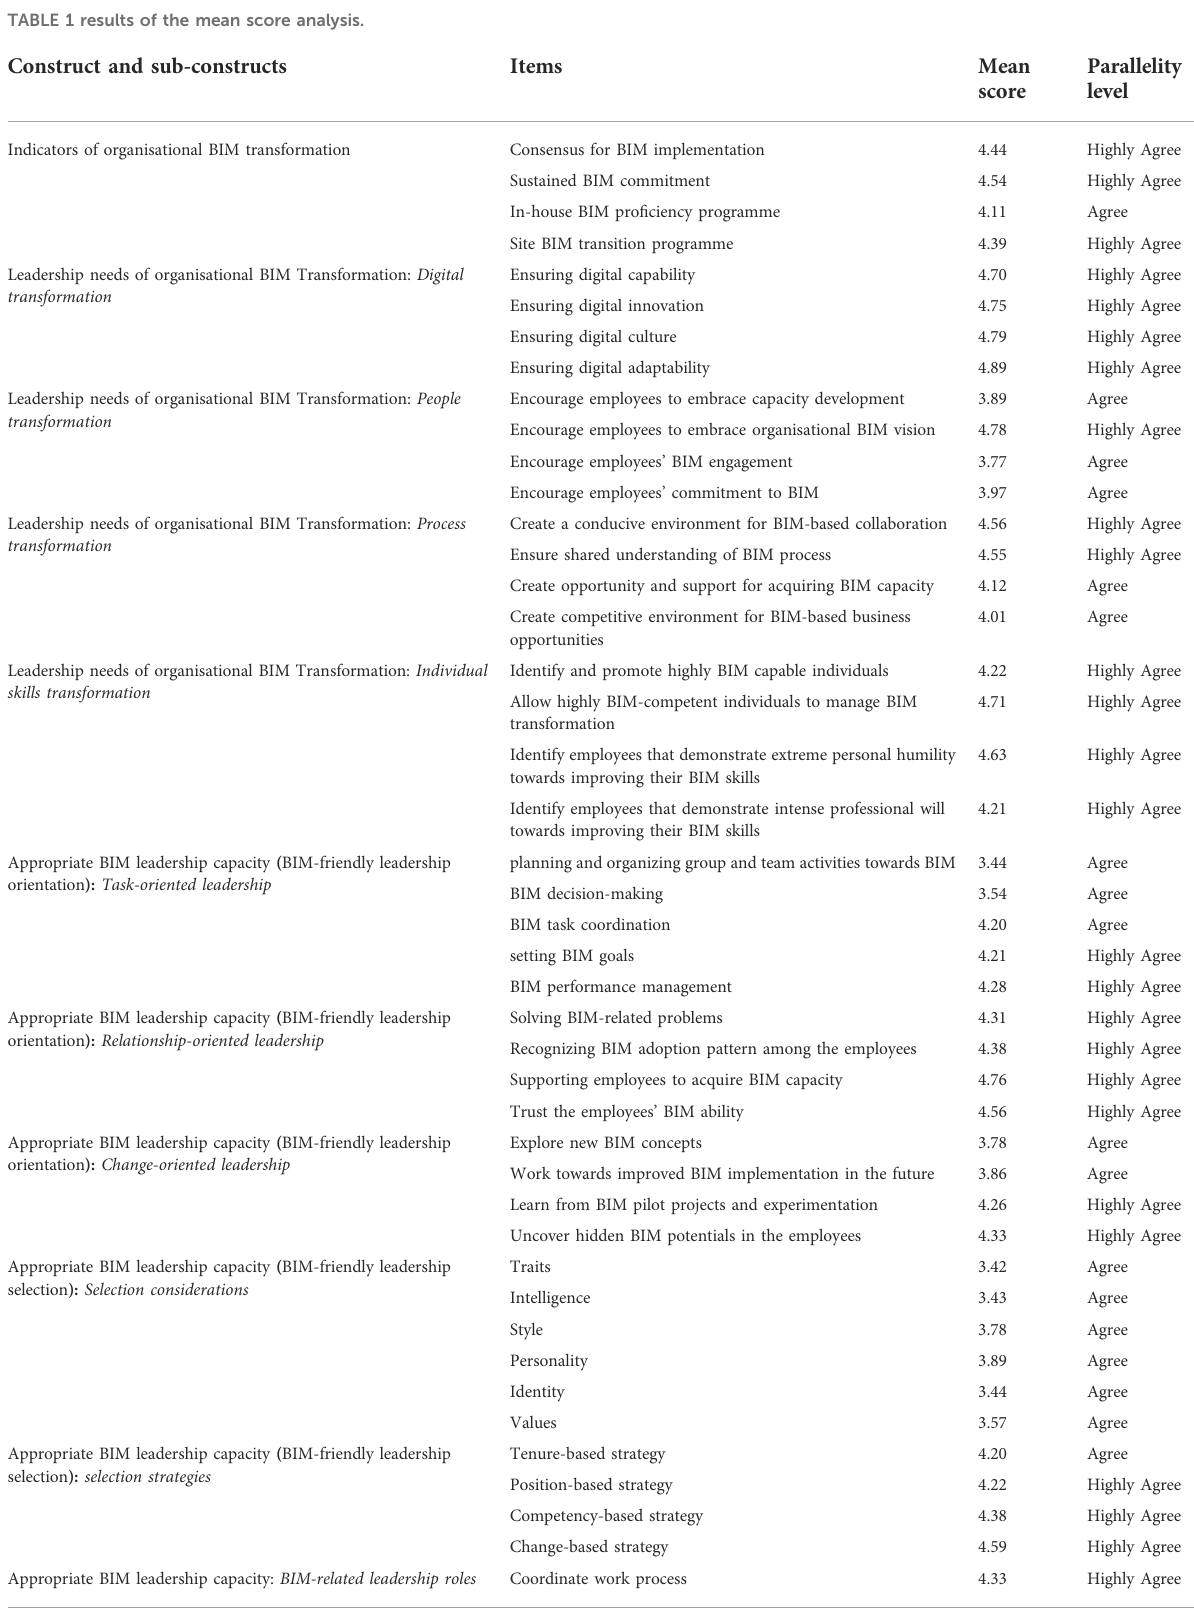
TABLE 1 results of the mean score